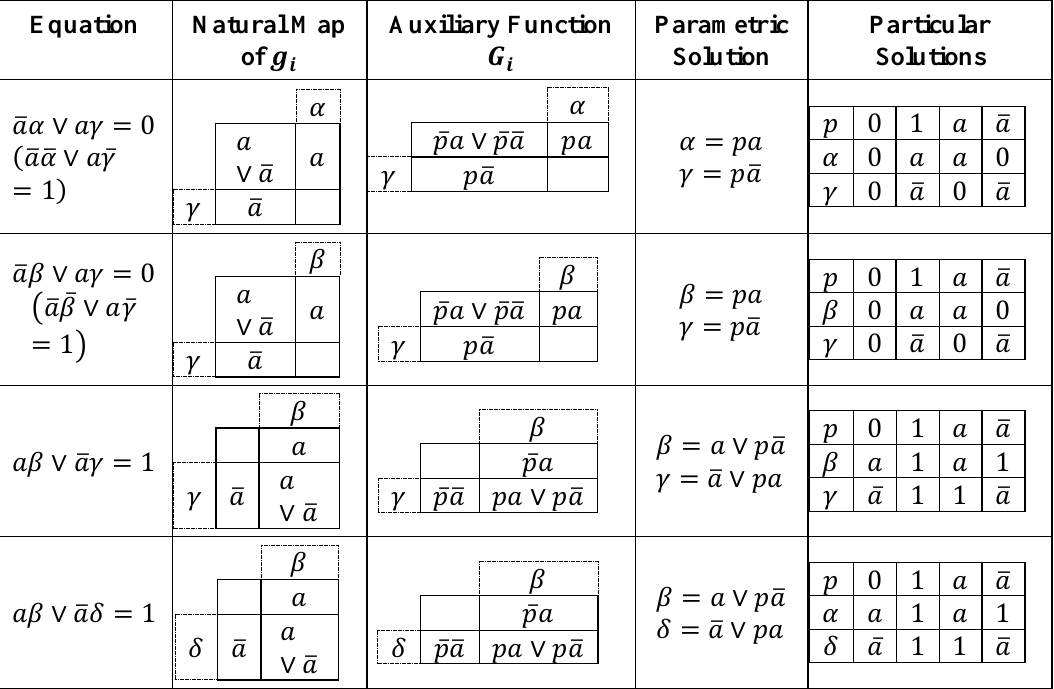
Table B1. Illustration of the solution of the Boolean equations in example 3 (revisited) Equation Natural Map Auxiliary Function Parametric Solution of 𝒈 𝑮 𝒊 𝒊